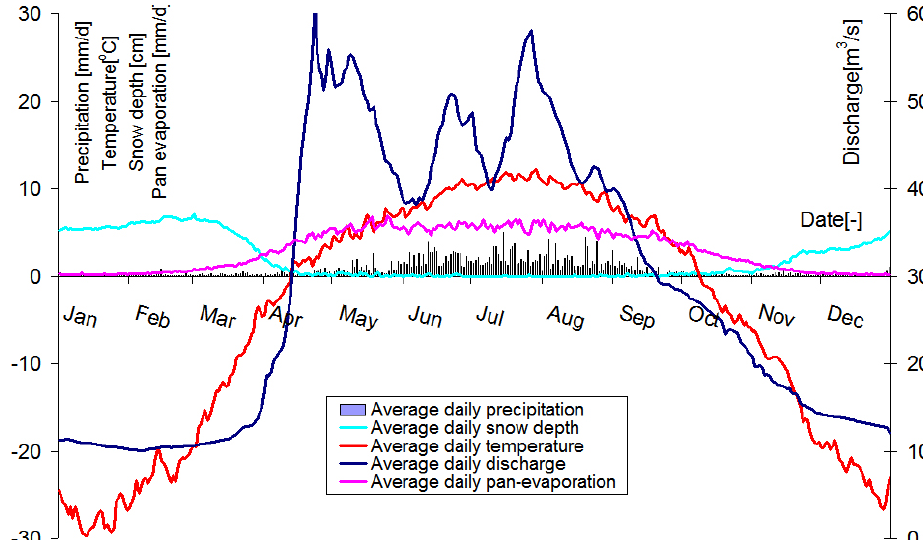
Fig. 2. Mean daily hydro-climatic variations throughout the year at BYBLK meteorological station inside the Kaidu basin.